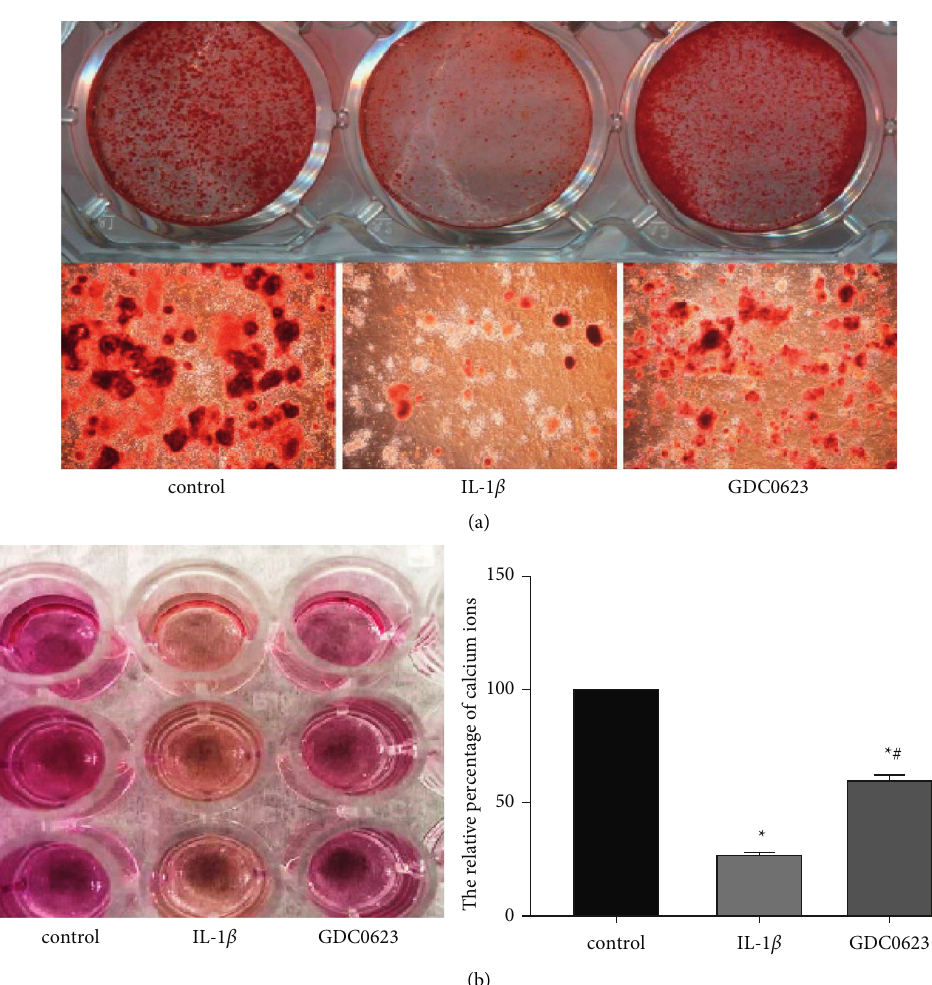
Figure 3: GDC0623 treatment affected calcified nodule formation and intracellular calcium levels. (a) Mineralized nodules were stained after osteoblast induction in the osteogenic differentiation medium for 21 days (upper lane), the details of mineralized nodules (lower lane). (b) Intracellular calcium levels were assessed by the calcium assay kit after treatment with the differentiation medium for 7 days. Data are expressed as mean ± SD for n � 3. ∗ p < 0.05 versus the control group, # p < 0.05 versus the IL-1 β